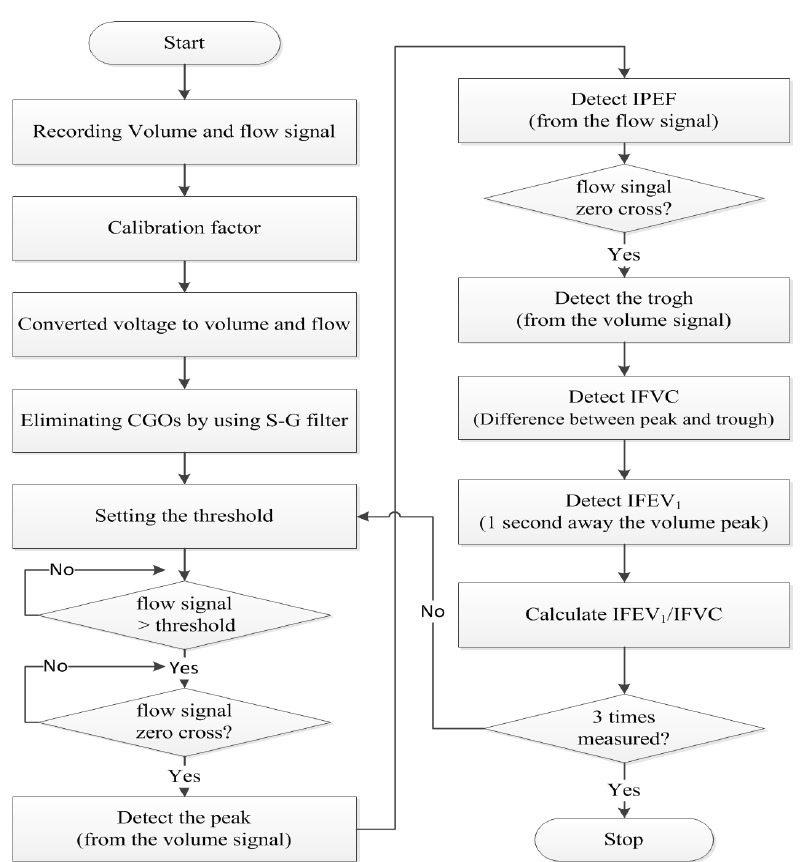
Figure 2. Flowchart for the detection of IPFS